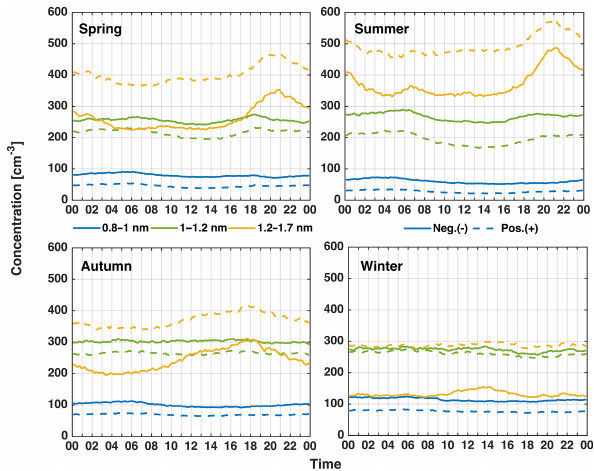
Figure 9. Median seasonality of the cluster ion concentration in 0.8–1, 1–1.2 and 1.2–1.7nm ranges over the years 2003–2006. Neg- ative ion concentrations are depicted by the solid line and positive ion concentrations by the dash